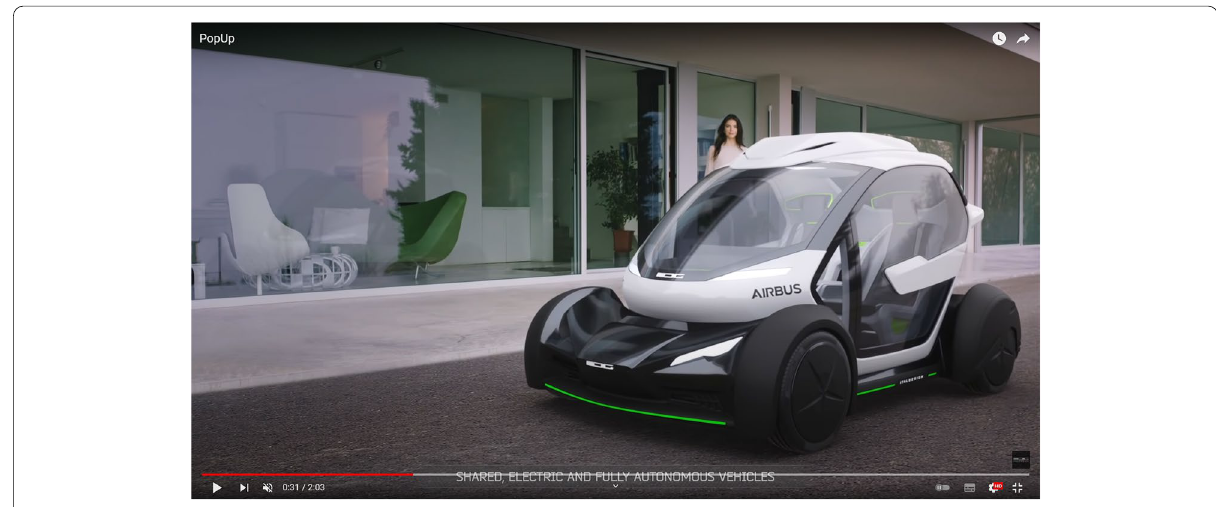
Fig. 4 The reveal of the